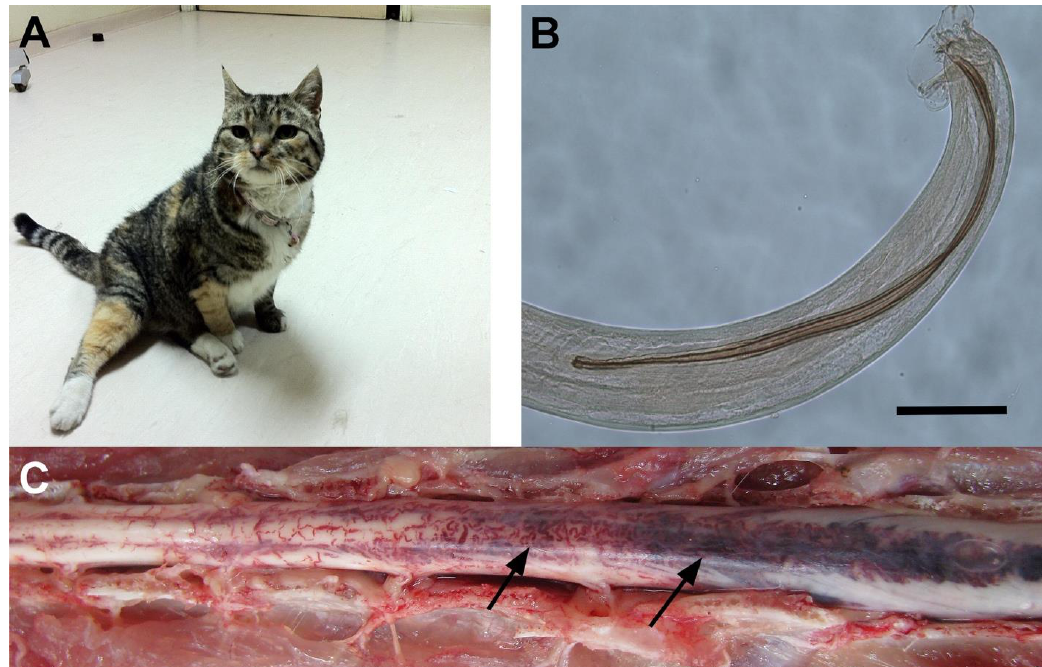
Figure 1. Clinical and pathological findings in a domestic cat with Gurltia paralysis infection. Adult domestic cat infected with G. paralysans with chronic paraparesis ( A ). Caudal end from an adult male specimen of G. paralysans (scale bar: 100 µ m) ( B ). Photograph from the lumbar spinal cord segments from a naturally infected cat with G. paralysans showing marked submeningeal vascular congestion (arrows) ( C